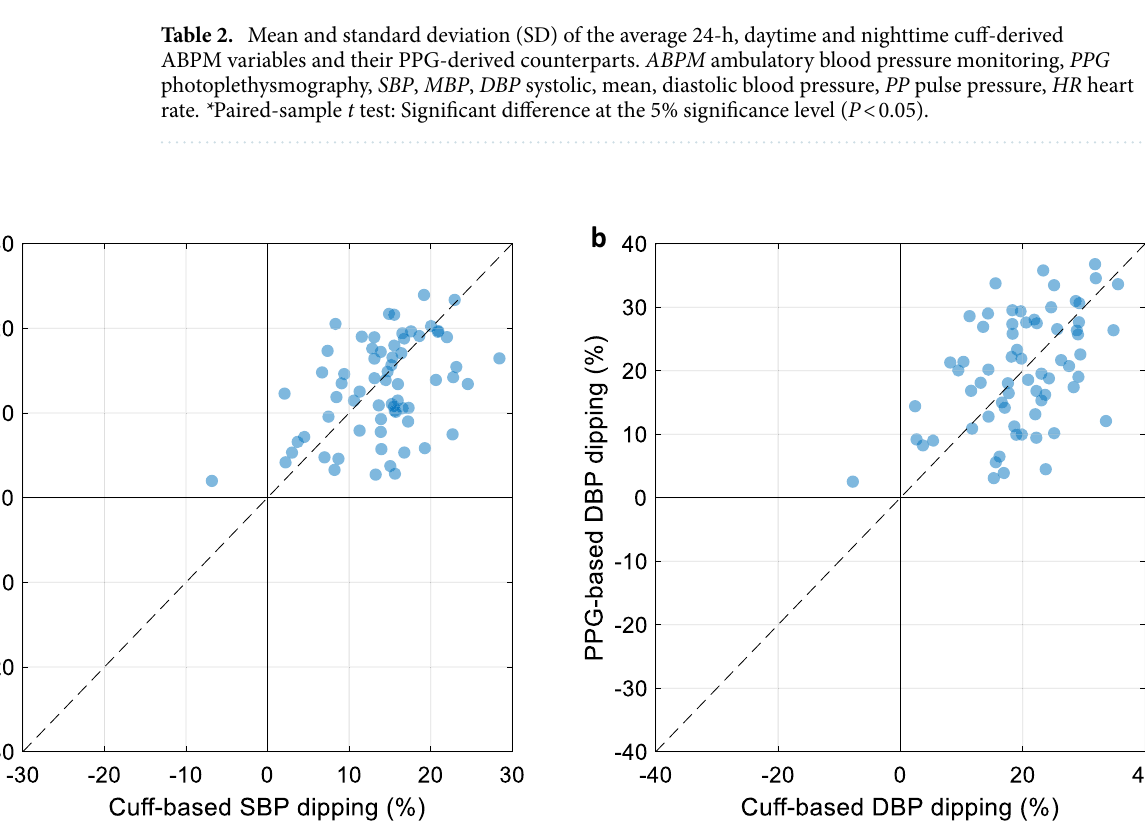
Figure 6. Four-quadrant plots comparing the PPG-derived nocturnal dipping estimates to their cuff-based counterparts for SBP ( a ) and DBP ( b ). PPG photoplethysmography, SBP systolic blood pressure, DBP diastolic blood